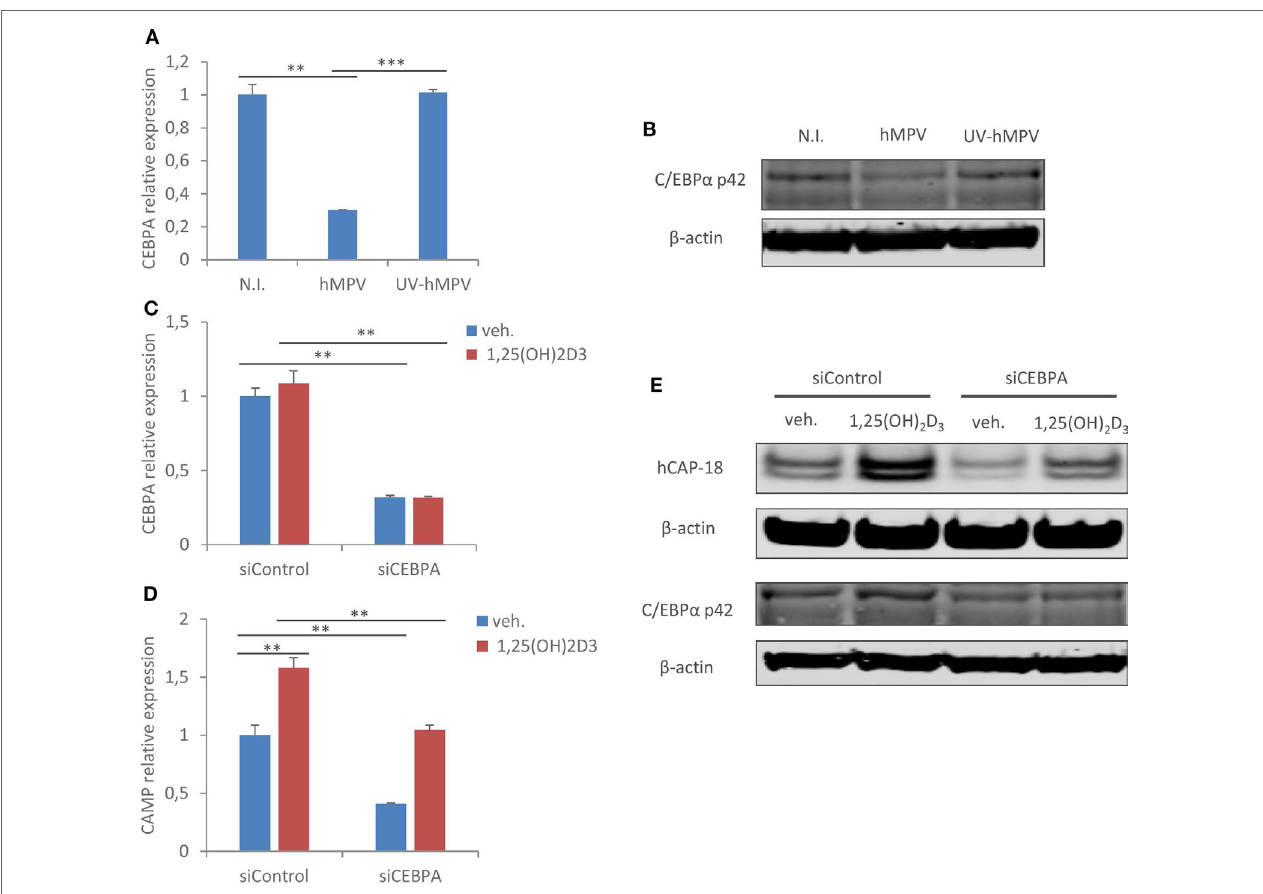
FigUre 5 | Human metapneumovirus (hMPV) infection inhibits C/EBP α expression, which is critical for cathelicidin antimicriobial peptide (CAMP) expression in human macrophages. (a,B) Monocyte­derived macrophages (MDMs) were mock­infected (N.I.), infected with hMPV (hMPV) or inoculated with UV­inactivated hMPV (UV­hMPV) for 24 h. C/EBP α mRNA (CEBPA) expression (a) and protein expression (p42) (B) was assessed by quantitative real­time PCR (qRT­PCR) and immunoblotting. (c–e) MDMs were transfected with siRNA targeting C/EBP α (siCEBPA) or scrambled control siRNA (siControl) for 72 h before vehicle or 1,25(OH) 2 D 3 treatment. mRNA expression of C/EBP α (CEBPA) (c) and CAMP (D) was assessed by qRT­PCR. C/EBP α (p42) and CAMP (hCAP­18) protein expression was assessed by immunoblotting (e) . Error bars represent SD for triplicates. ** p < 0.01, *** p < 0.001. Data are representative of at least three independent experiments from different donors. Full­length blots are presented in Figure S1 in Supplementary